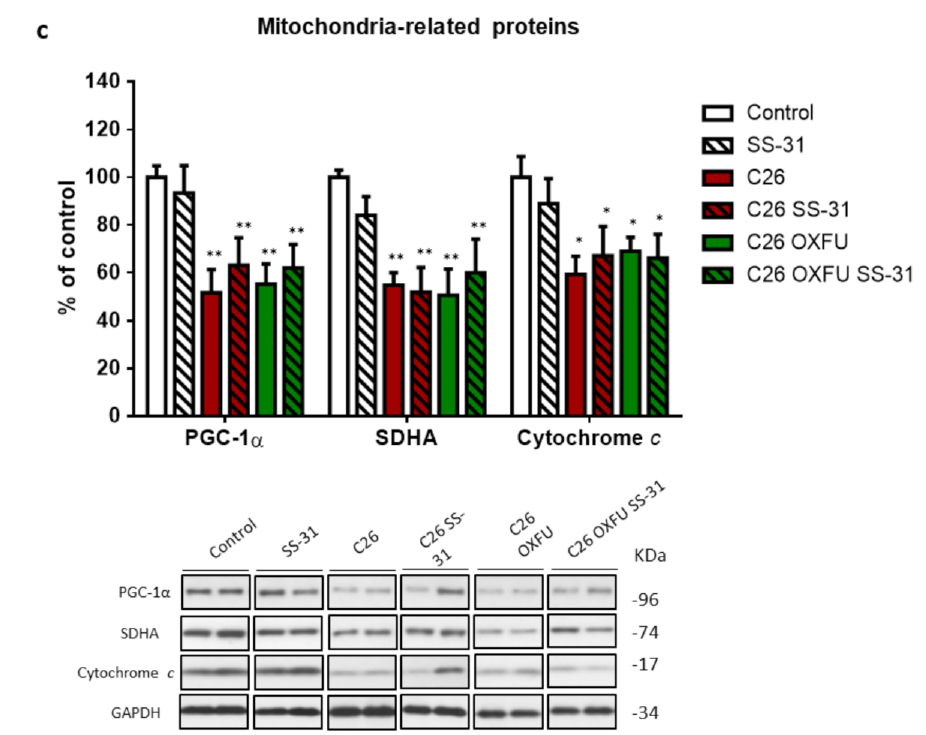
Figure 2. SS-31 improves mitochondrial activity without modulating protein expression. Muscle SDH total activity ( a ), ATP content ( b ) and mitochondrial marker proteins (quantification and representative blot; ( c ) of controls ( n = 7), SS-31-treated mice (SS-31; n = 6), tumor-bearing mice (C26; n = 8), SS-31-treated tumor-bearing mice (C26 SS-31; n = 8) and tumor-bearing mice administered with chemotherapy alone (C26 OXFU; n = 8) or in combination with SS-31 (C26 OXFU SS-31; n = 8). SDH activity (means ± SEM) is expressed as the ratio between absorbance and total protein content. ATP content (means ± SEM) is expressed as absolute concentration (mM). Protein data (means ± SEM) are expressed as a percentage of control. Significance of the differences: * p < 0.05, ** p < 0.01 vs. control; # p < 0.05 vs.